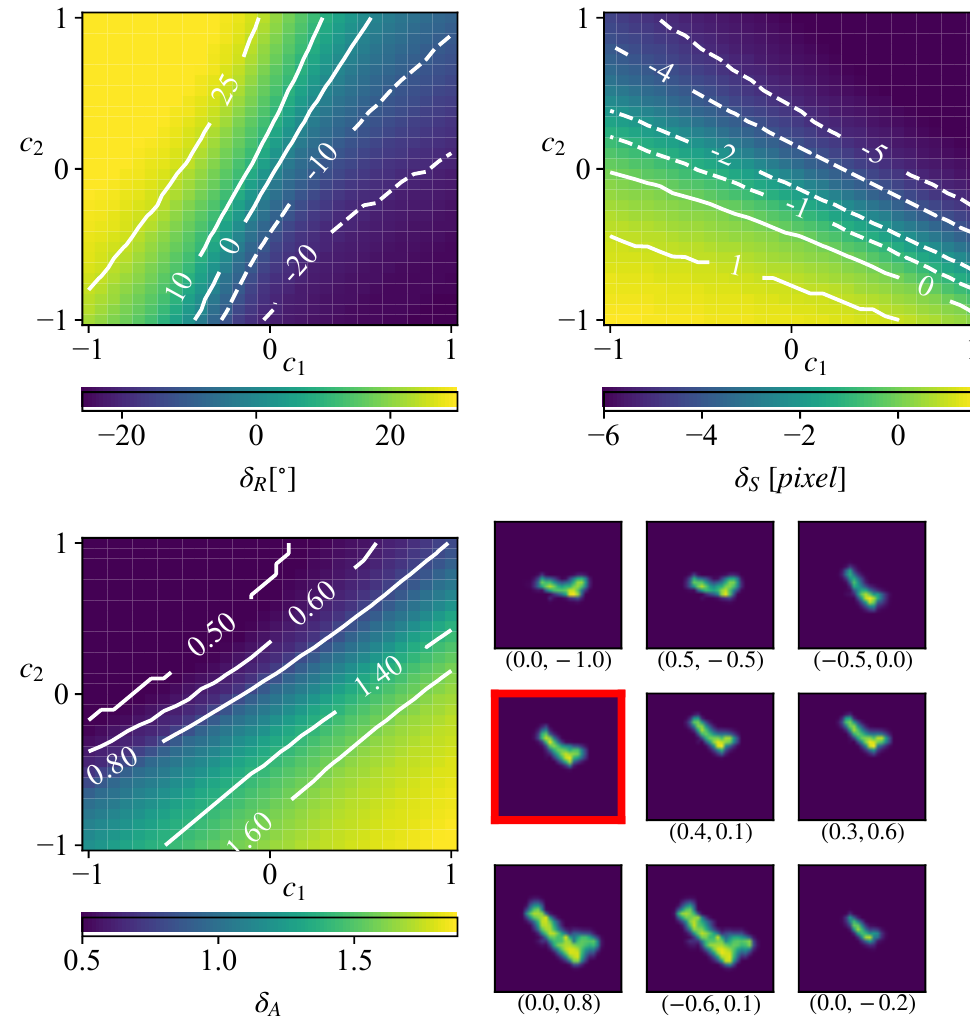
Figure 9. The relation between each property and two latent codes. The relation between rotation angle δ R and c 1 , c 2 ( top-left ). The relation between translation pixels δ S and c 1 , c 2 ( top-right ). The relation between scaling δ A and c 1 , c 2 ( bottom-left ). The synthesized SAR images corresponding to ( c 1 , c 2 ) labeled below each image except for the original image (marked by red square) ( bottom- right ). In this panel ( bottom-right ), the first two images in the top row exhibit the same rotation angle δ R with different c 1 and c 2 , i.e., c 1 = 0.0, c 2 = − 1.0 and c 1 = 0.5, c 2 = − 0.5, both resulting in − 20 ◦ rotation. The third one in the top row shows δ = 25 ◦ with c = − 0.5 and c = 0.0. These R 2 1 figures further demonstrate the solution to (31) is not unique; thus, it is possible to retain or change property by manipulating c 1 and c 2 . This conclusion is also applicable to translation δ S and scaling δ A , as shown in the second and the third rows ( bottom-right